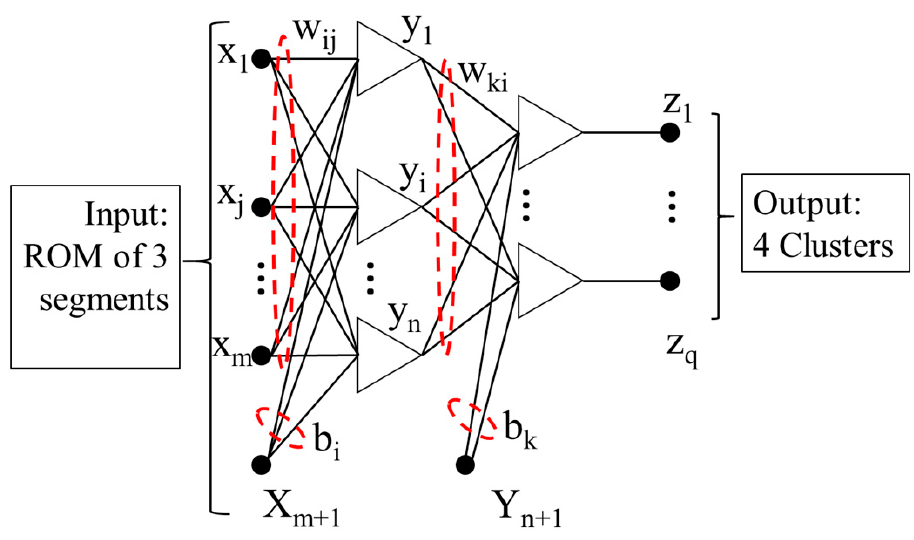
Figure 3. Artificial neural network (ANN) structure (weights and biases are highlighted in red dotted circle)